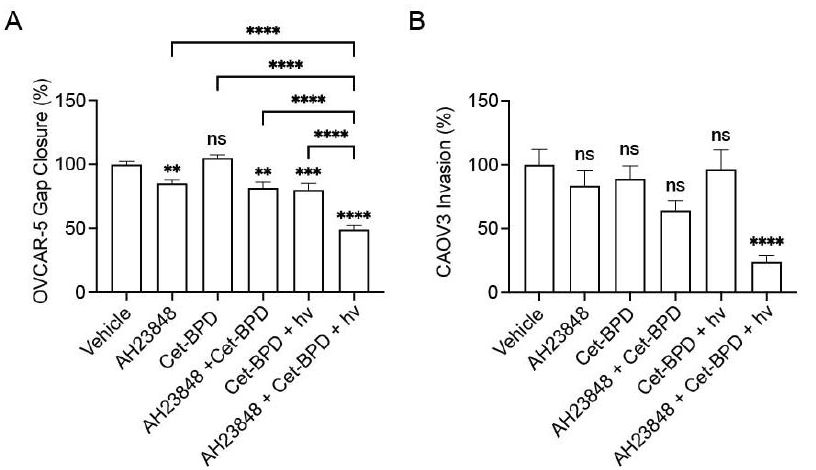
Figure 4. Investigation of anti-metastatic effects of Cet-BPD-based PDP combined with EP4 inhibi- tion (AH23848). Treatments are evaluated in gap closure assays using OVCAR-5 cells ( A ) and transwell invasion assays using CAOV3 cells ( B ). All data are normalized to the vehicle (DMSO) control, and statistical analysis was performed using a one-way ANOVA and post hoc Tukey’s test. Error bars represent the standard error of the mean. ** p ≤ 0.01; *** p ≤ 0.001; **** p ≤ 0.0001; ns: nonsignificant.